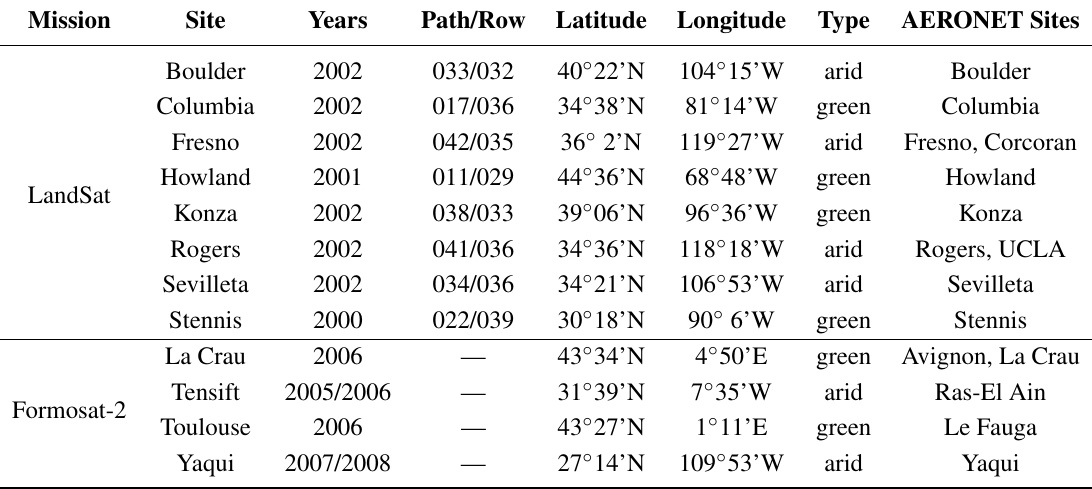
Table 2. Sites used in the study. AERONET, Aerosol Robotic